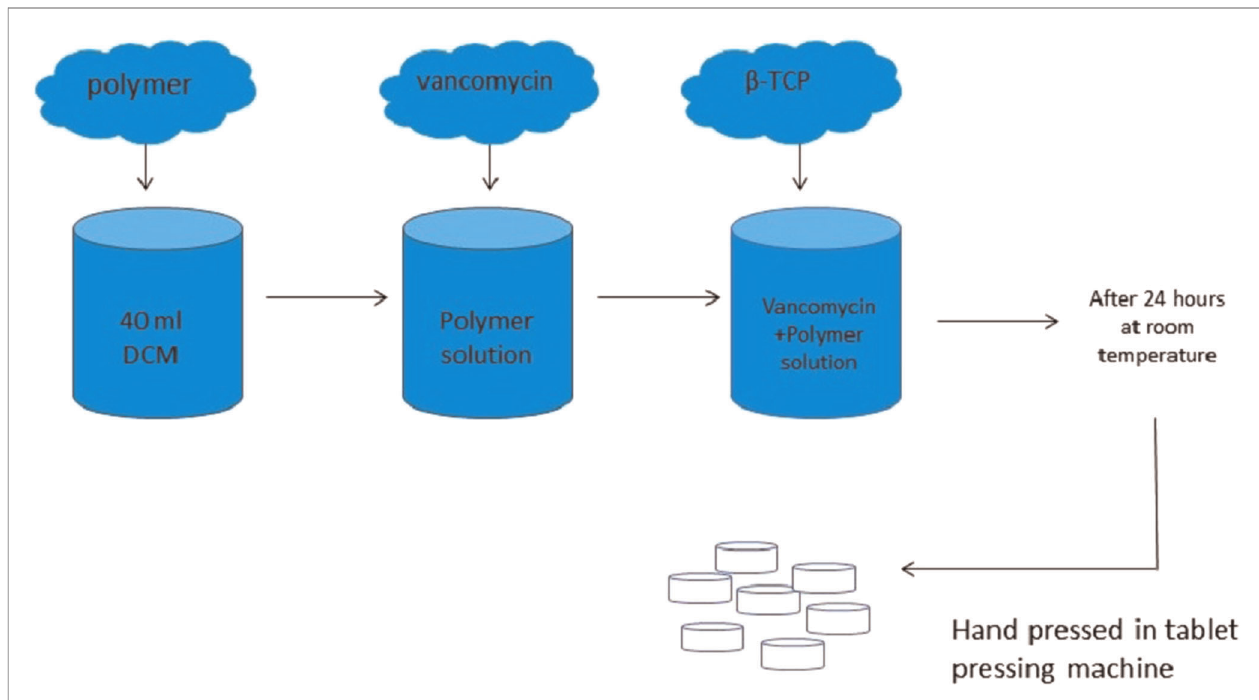
FIGURE 1 | The design of the